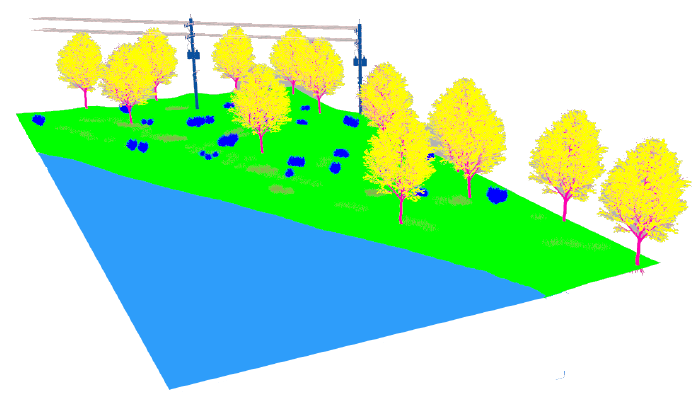
Figure 14. The plain visual model of the lake environment.